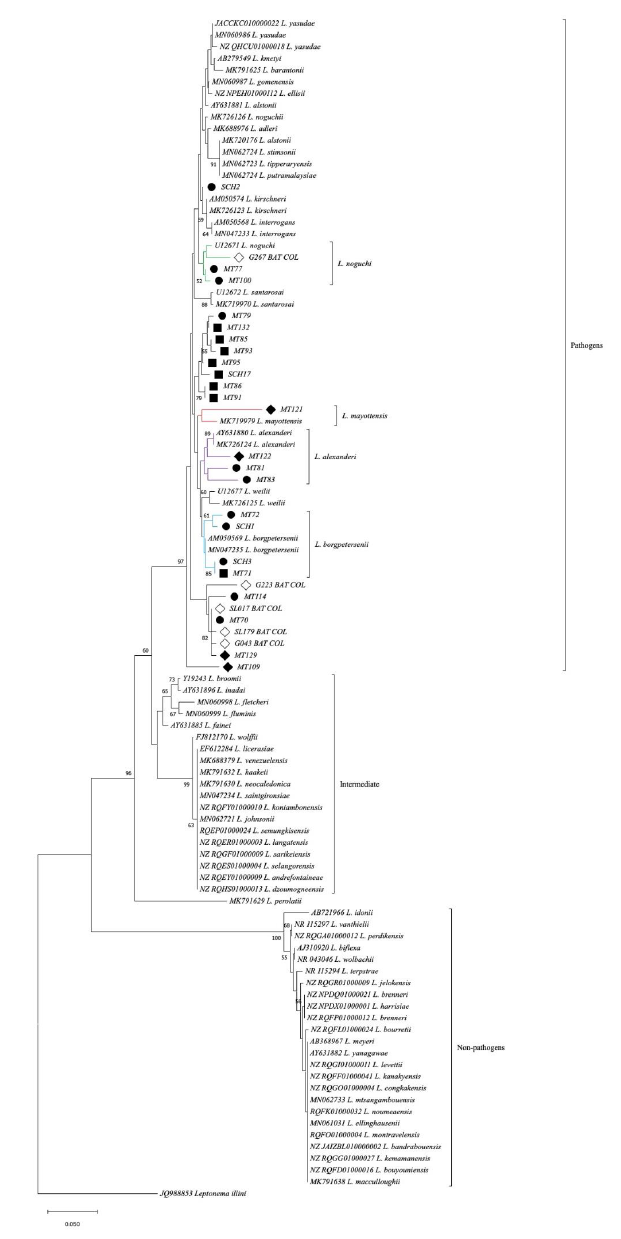
Figure 1. Leptospira spp. 16S rRNA sequence-based phylogenetic tree detected in bats. Sequences retrieved from this study are indicated by symbols: black circles from N. tumidirostris , black squares from M. megalophylla , and black rhombuses from C. perspicillata. The GenBank numbers from the reference sequences are indicated in brackets, and the Leptospira spp. sequences obtained from previous Colombian bat species studies are indicated by white rhombuses [21]. The Leptospira species and their groups are listed to the right of each